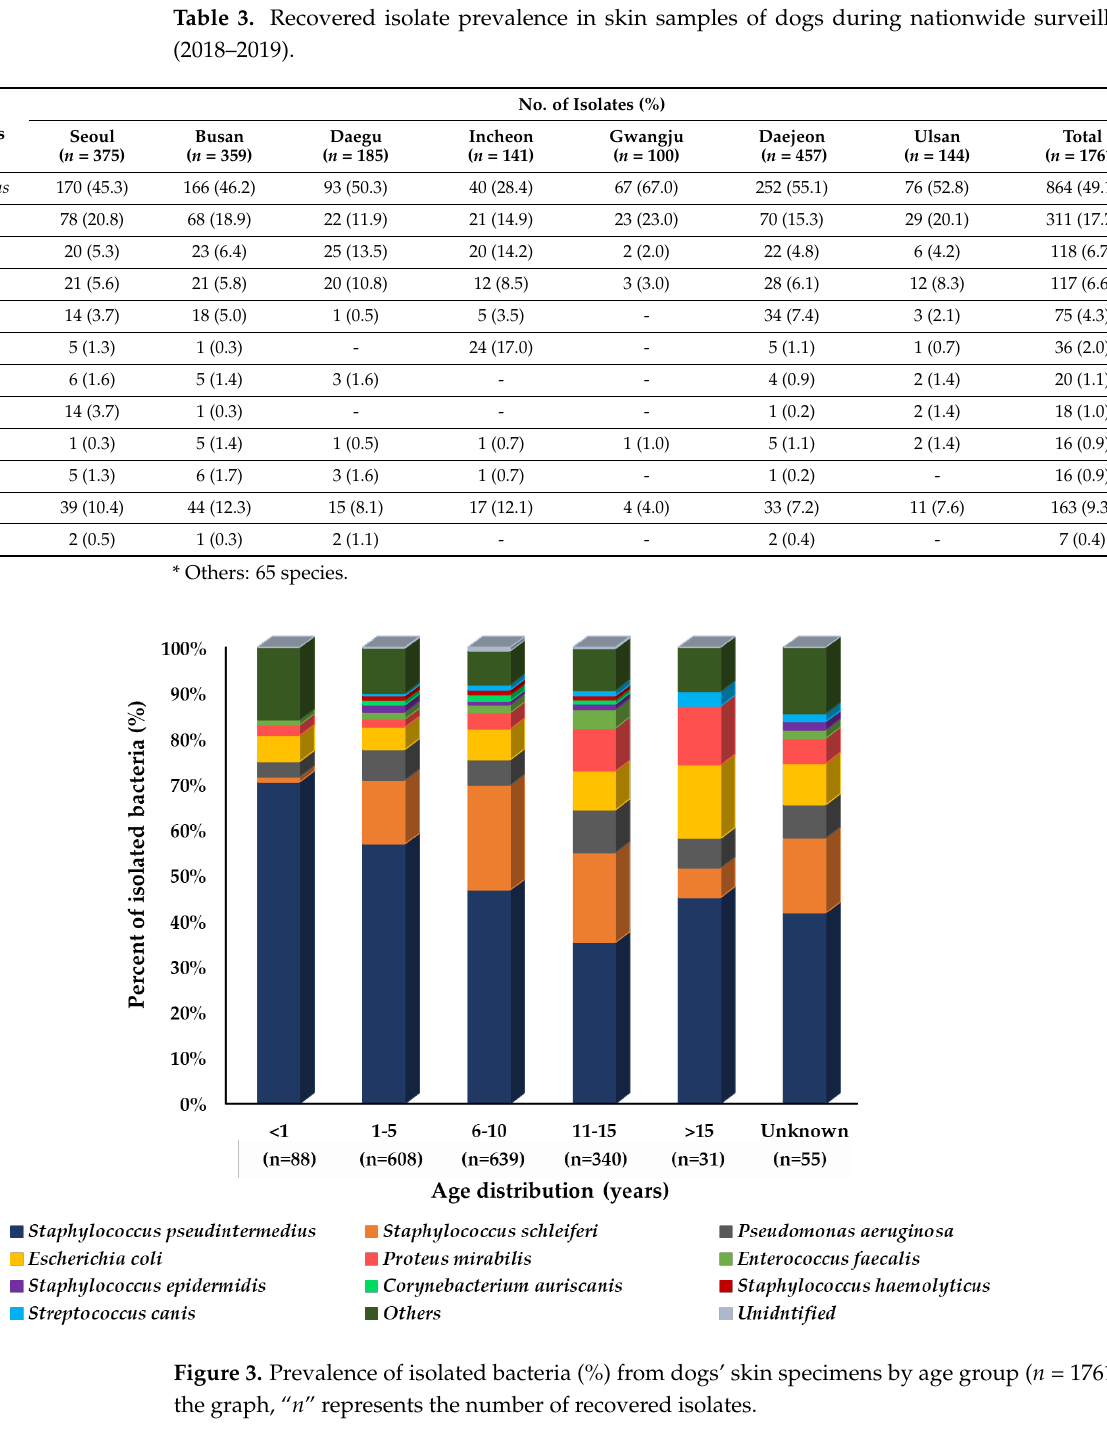
Table 3. Recovered isolate prevalence in skin samples of dogs during nationwide surveillance (2018 – 2019).